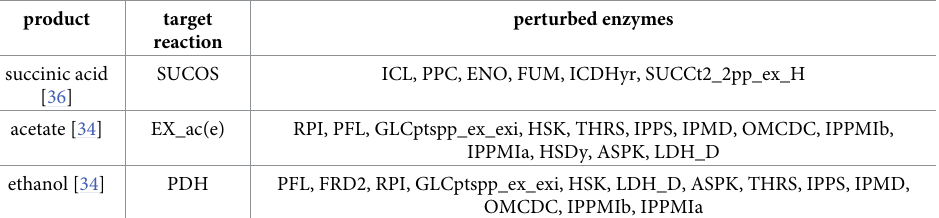
Table 1. List of the investigated products of interest and the corresponding enzymes whose levels were optimized, selected based on [34] and [36].